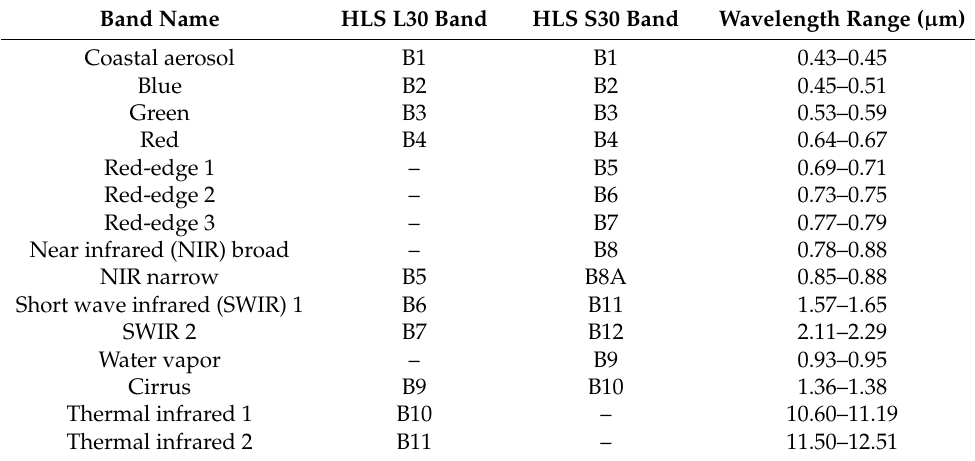
Table 1. Band parameters of the HLS L30 and S30 surface reflectance products.